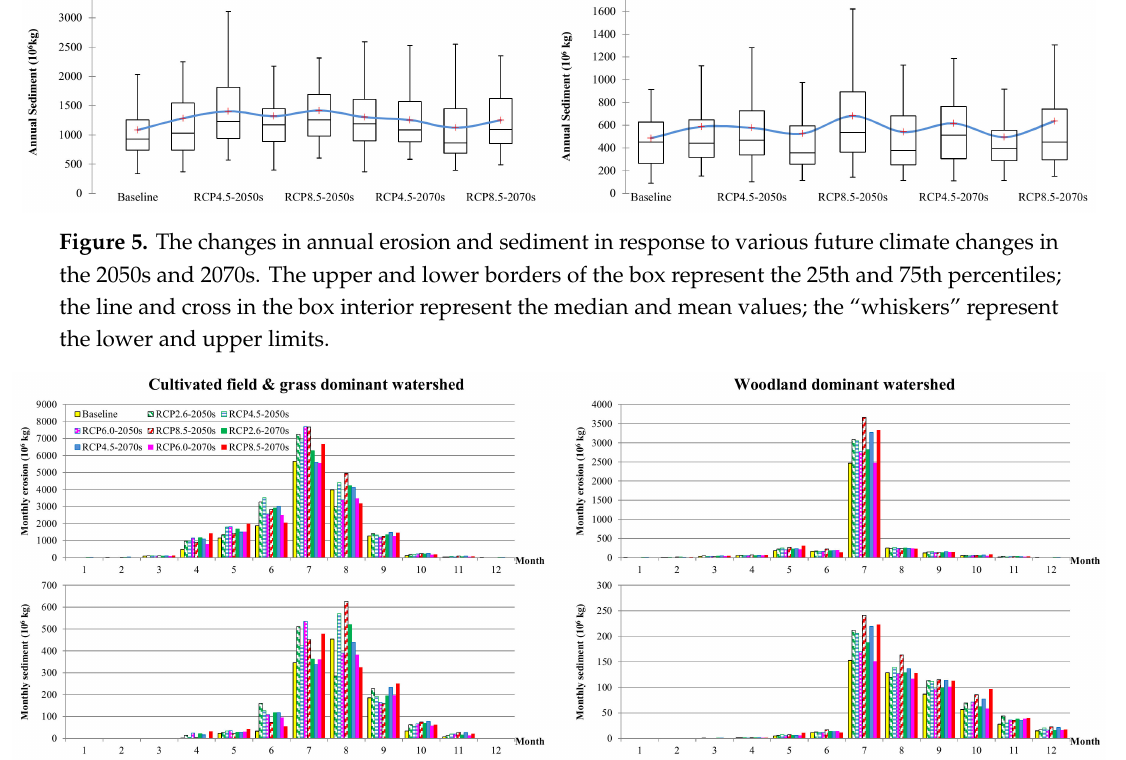
Figure 6. The changes in monthly erosion and sediment in response to various future climate changes in the 2050s and